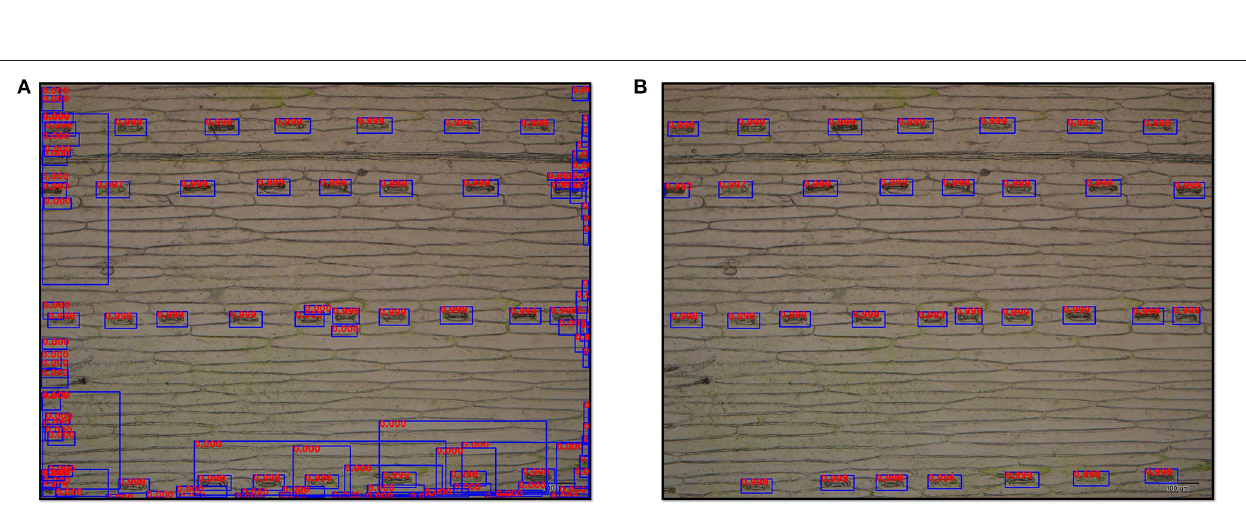
FIGURE 5 | Output images of stomata detection results by the Faster R-CNN-based model at bboxes (112 bboxes), and the number on the bbox represents its detection score. (B) Detection result after filtering (32 stomata).